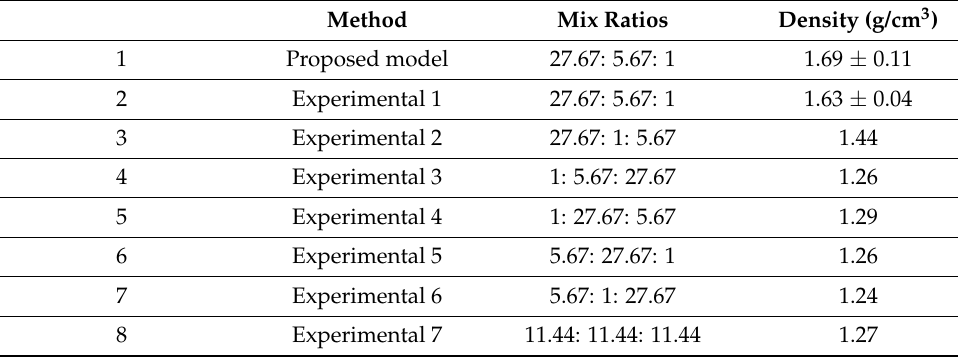
Table 5. Different Mix Ratios and their